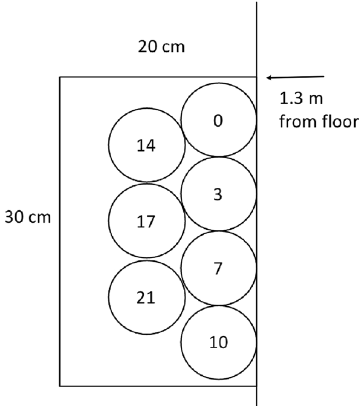
Figure 2. Location of curtain sampling by study day. The circles indicate the location of contact plate sampling on each day, to minimize the potential effect of residual agar left on the curtain from a prior day’s